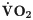
Sprint and recovery pulmonary oxygen uptake (V˙O2) expressed as a percentage of V˙O2peak for control (CTRL), inspiratory muscle loading (INSP) and worked matched (MATCH) exercise.The symbols represent comparisons between INSP and CTRL (⁕), INSP and MATCH (#). The number of symbols; one, two and three denote likely, very likely and almost certainly respectively, that the chance of the true effect exceeds a small (-0.2–0.2) effect size. Vales are presented as mean ± SD.